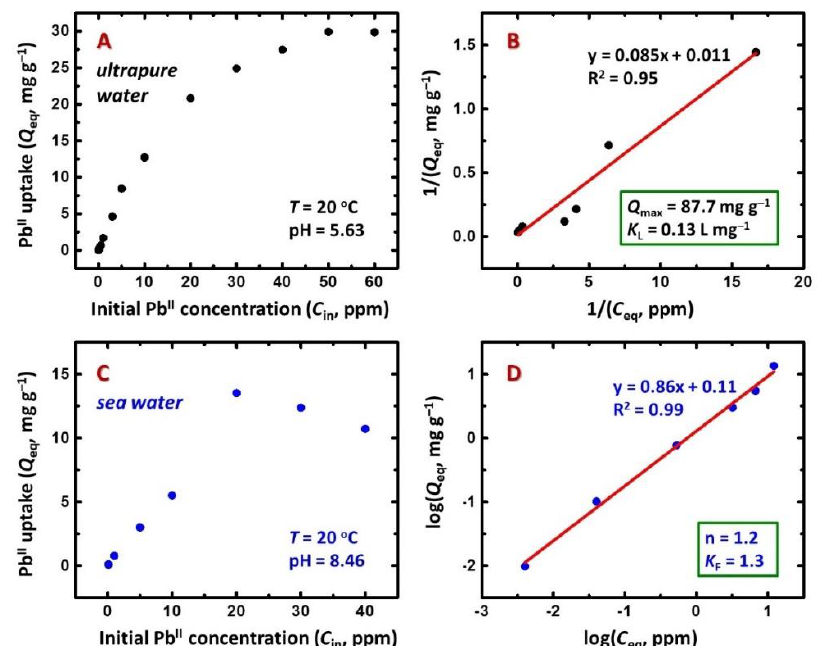
Figure 1. Isotherms for Pb II uptake from ultrapure water (top row) and seawater (bottom row) so- lutions by X-Ca-alginate aerogel beads. ( A , C ) Pb II uptake at equilibrium ( Q eq ) versus the initial con- centration of Pb II ( C in ). ( B ) Langmuir isotherm. ( D ) Freundlich isotherm. C eq is the concentration of Pb II in the solution at equilibrium.